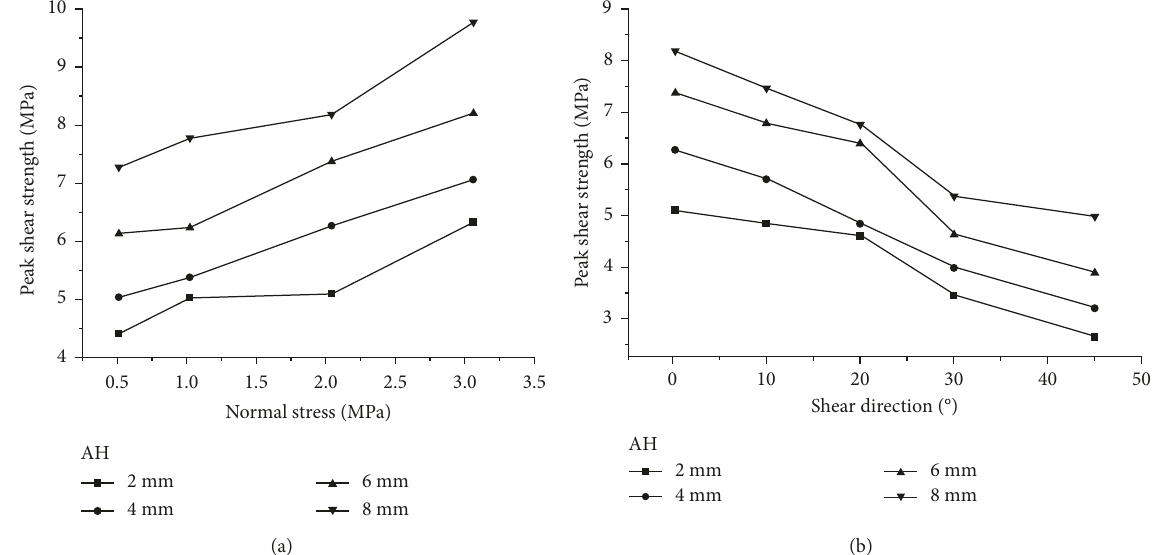
Figure 15: Relationship between shear direction as well as normal stress and peak shear strength. (a) Different normal stresses (SD (b) different asperity heights (NS